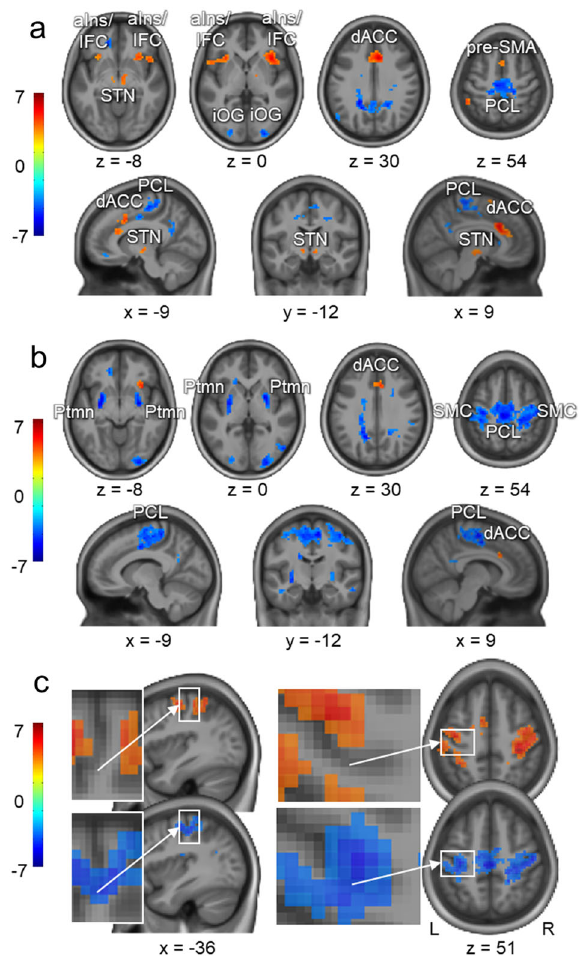
Fig. 4 Changes in activity during errors and position-matched sequences. a Activation maps with main effect of errors (i.e., errors versus rest). b Activation map with areas exhibiting signi fi cant changes in BOLD signals during errors versus their position-matched sequences (i.e., control error- free condition). c Regions within the sensorimotor and premotor cortices that exhibit signi fi cant activity increases during the control condition, versus rest (i.e., main effect of position-matched sequences; for additional cortical and subcortical areas see Supplementary Fig. 5), and signi fi cant activity decreases during errors versus the control condition (i.e., the same contrast as in b ). Note that sensorimotor hand area within the left hemisphere (i.e., ipsilateral to the performing hand; the enlarged area) is not signi fi cantly engaged during the control condition, but undergoes suppression during errors. Activation maps were thresholded at p < 0.001. Color bars represent t values. L/R - left/right hemisphere, dACC - dorsal anterior cingulate cortex, pre-SMA - pre-supplemental motor area,